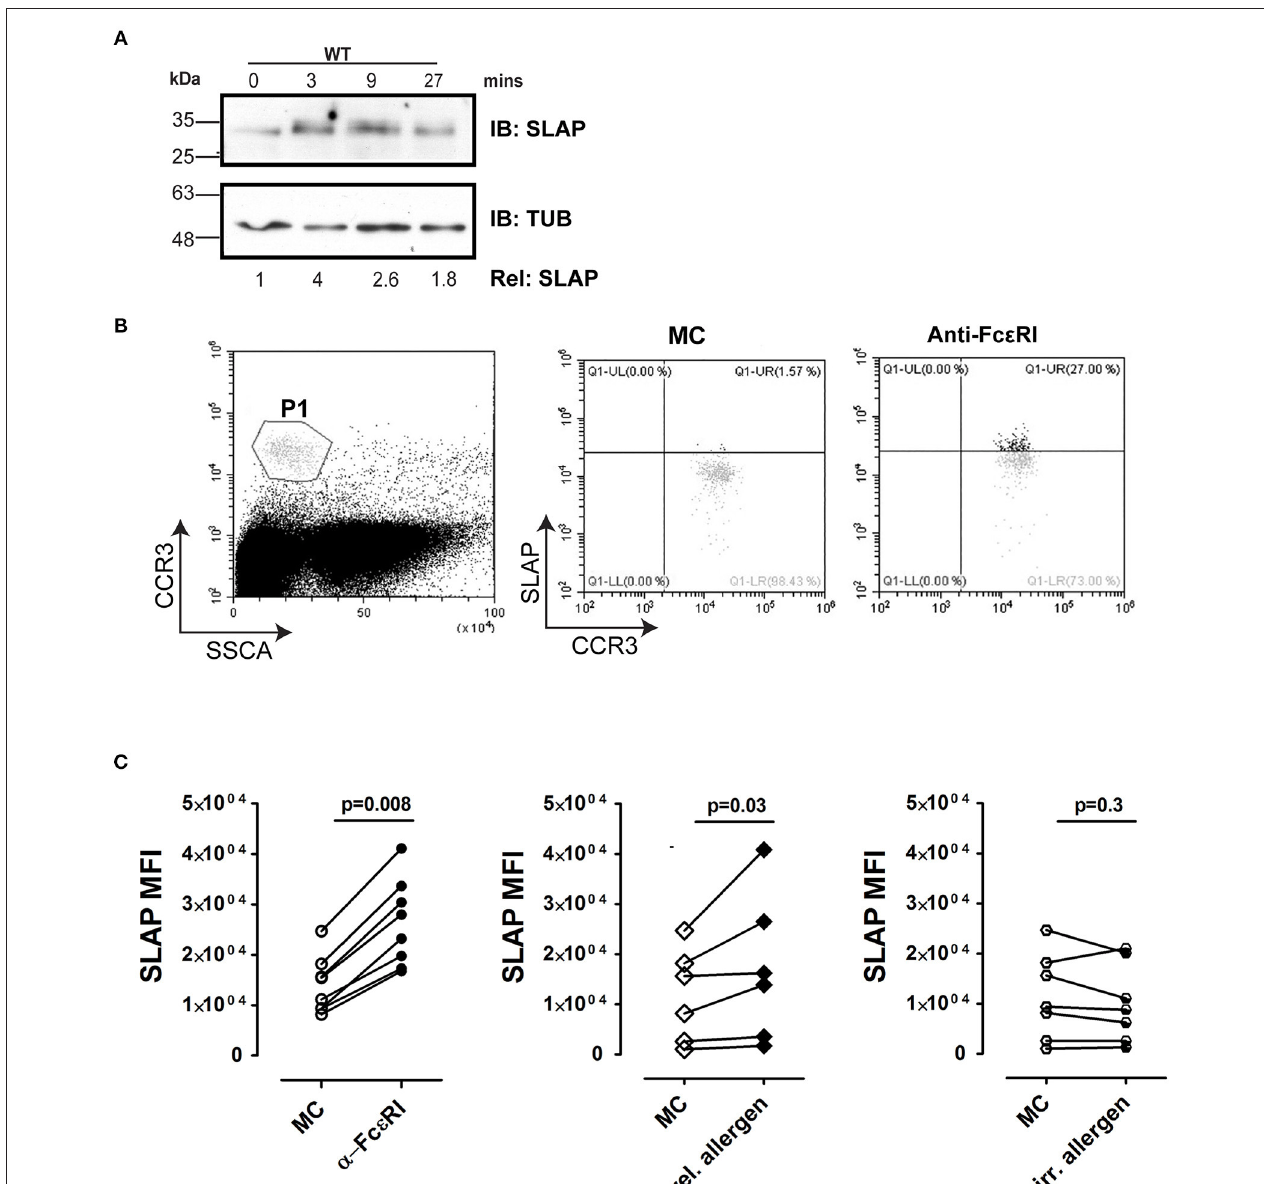
FIGURE 9 | SLAP expression is regulated by Fc ε RI signaling in BMMCs and human basophils. (A) WT and SLAP KO BMMCs were starved and sensitized with anti-DNP IgE for 18h and then stimulated with DNP-HSA (50ng/ml) for indicated time-points. Lysates were prepared and subjected to immunoblot (IB) with anti-SLAP, and anti-tubulin (TUB) Abs. Results are representative of three separate experiments ( n = 3). Densitometry was performed to determine the relative SLAP protein levels (the WT level at 0min was set as 1.0). Positions of relative mass markers in kilodaltons (kDa) are shown on the left. (B) Gating strategy for basophils in human samples . Basophil were identified as CCR3 hi /SSC low , indicated as P1 in dot plot. SLAP expression was quantified in P1 population by intracellular staining with anti-SLAP and flow cytometry. (C) Basophils from atopic donors were incubated with human Fc blocking antibody and then treated with medium control (MC) or stimulated with anti-Fc ε RI antibody [positive control, ( n = 8), relevant (allergic, n = 4)] or irrelevant allergen ( n = 5) and stained with anti-SLAP Ab. The median fluorescence intensity of intracellular staining of SLAP with and without stimulation of each donor sample is shown. Wilcoxon matched-pairs signed-rank test was used to calculate statistical